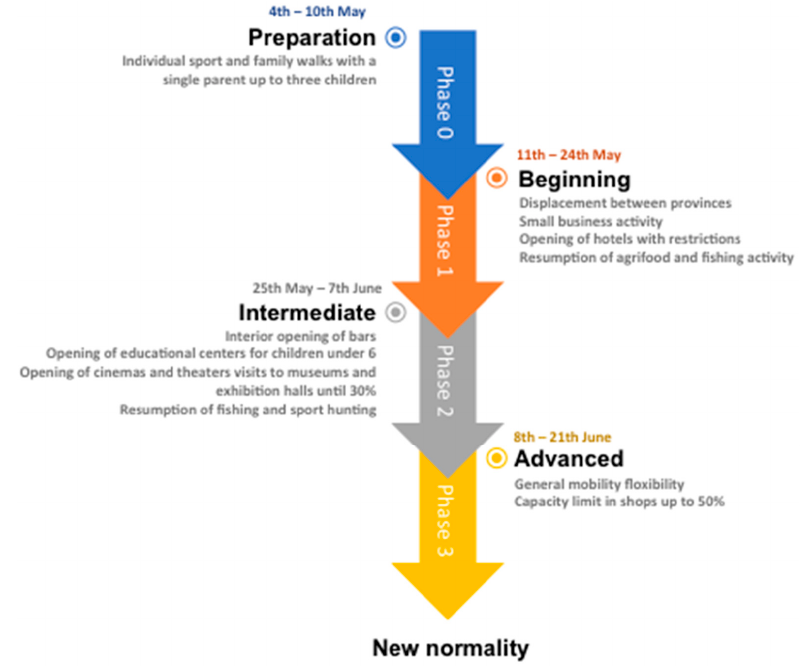
Figure 1. Phases of de-escalation.